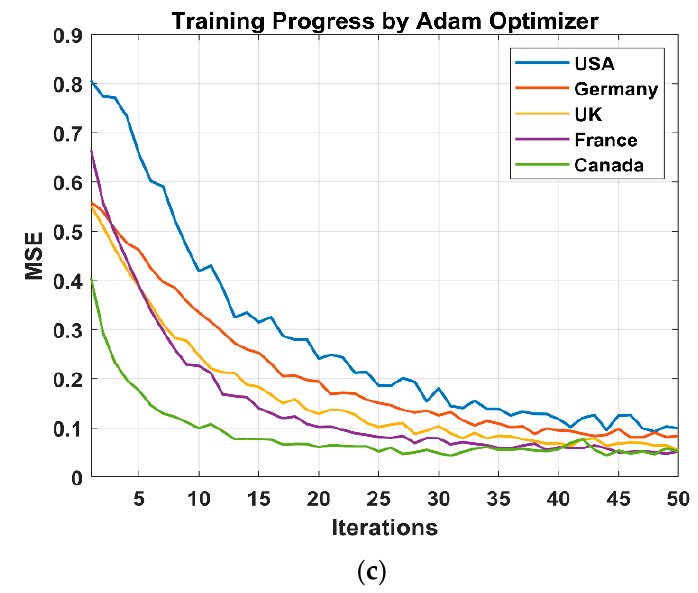
Figure 7. The performance plot of NN training by optimizer mean squared error (MSE) vs. iterations-monkeypox. ( a ) ANN; ( b ) LSTM; ( c ) GRU.